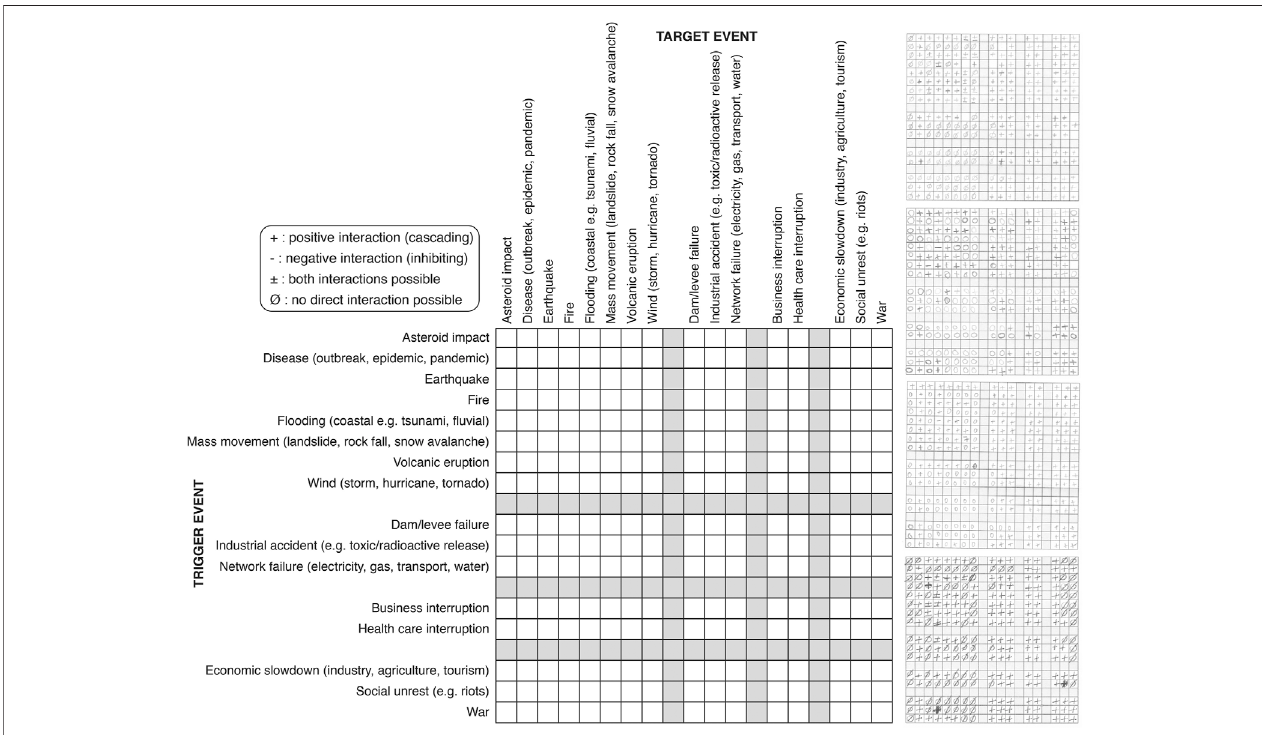
FIGURE 3| The pen-and-paper exercise de fi ned and tested in Mignan et al. (2016). Participants fi lled in the adjacency matrix shown on the left, indicating whether one-to-one interactions were possible ( + , − , ±) or not ( Ø ). Three types of interactions were considered: triggering ( + ), inhibiting ( − ), and both (±). Four examples of fi lled adjacency matrices are shown on the